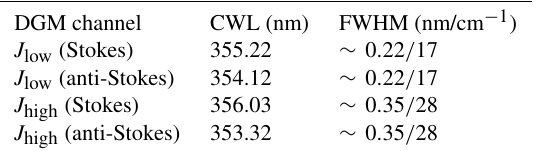
Figure 12. (2 October 2014) Temperature profile retrieved using Eq. (11). The absolute and relative uncertainties (cid:49)T = (cid:49)T and ((cid:49)T/T ) = ((cid:49)T /T ) are calculated by Eqs. (A21) and (A22), respectively. Table 2. Spectral selection parameters of the DGM channels (cen- tral wavelength (CWL) and full width at half maximum